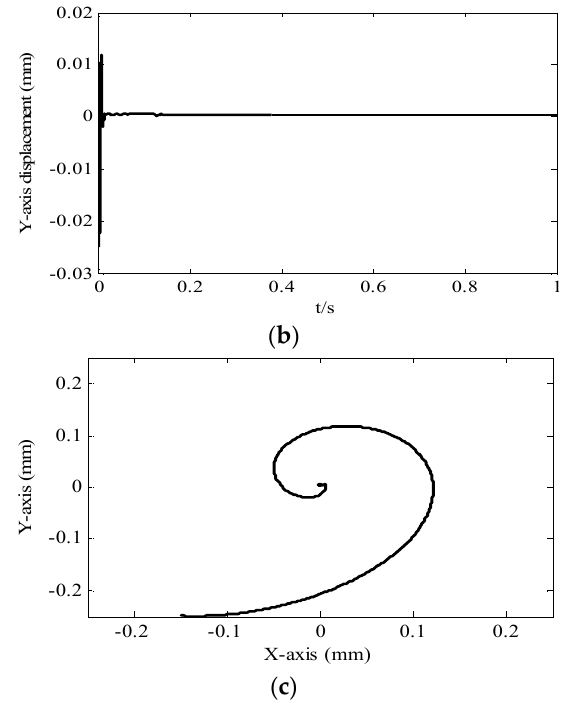
Figure 6. Waveforms of the rotor radial displacement controlled by ASMC (12,000 r/min): ( a ) The radial displacement on the x ‐ axis; ( b ) the radial displacement on the y ‐ axis; ( c ) the curve of rotor operation.